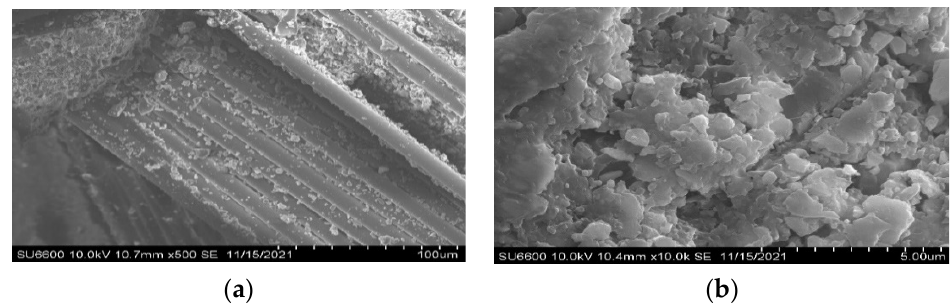
Figure 5. SEM images for 10%SiCE at 10kV with magnifications ( a ) 500 ( b )10000